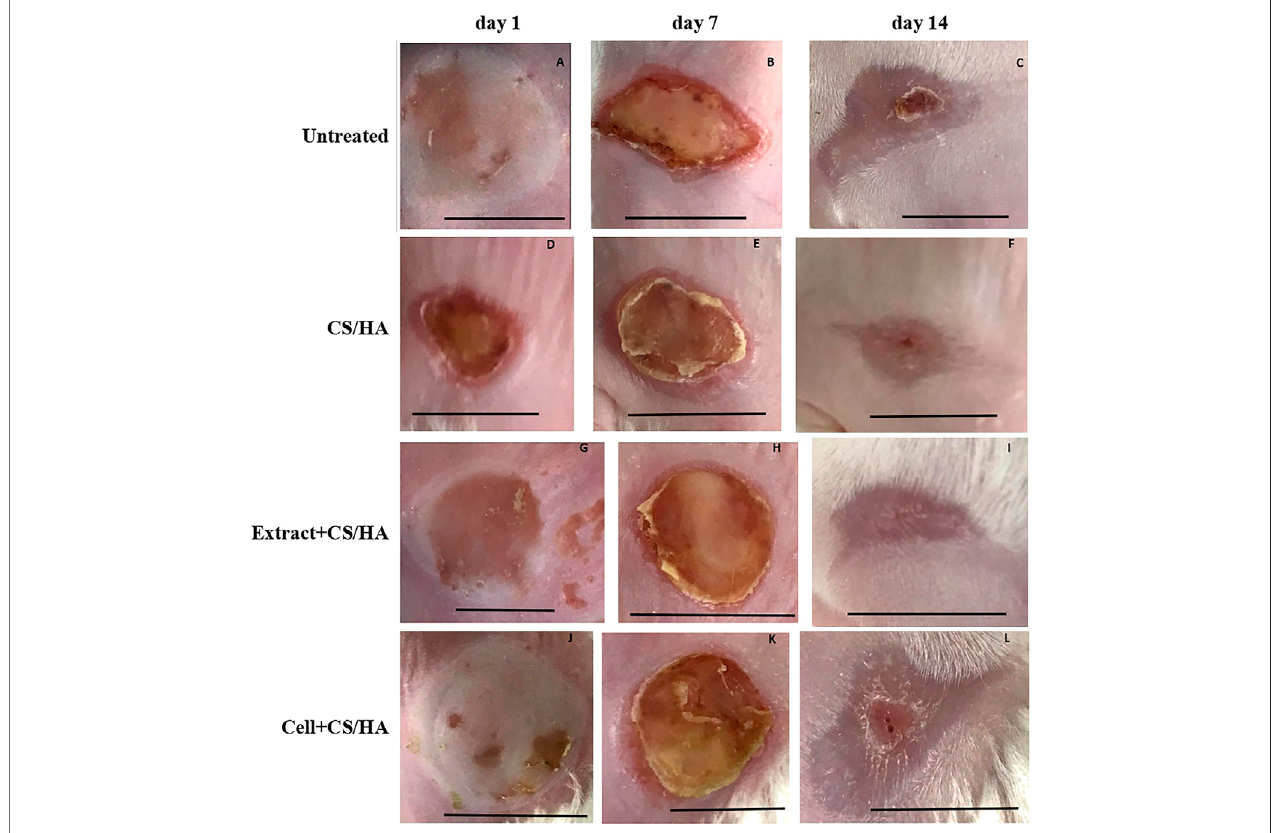
FIGURE1| Macroscopicappearance ofwoundstreatedwithCS/HA,extract+CS/HA,and cell+CS/HAat 1,7,and 14days inthemice. (A – C) Untreated( n (cid:1) 1). (D – F) CS/HA ( n (cid:1) 7). (H – J) Extract + CS/HA ( n (cid:1) 7). (K, L) Cell + CS/HA ( n (cid:1) 7). Scale bar (cid:1) 1 cm.